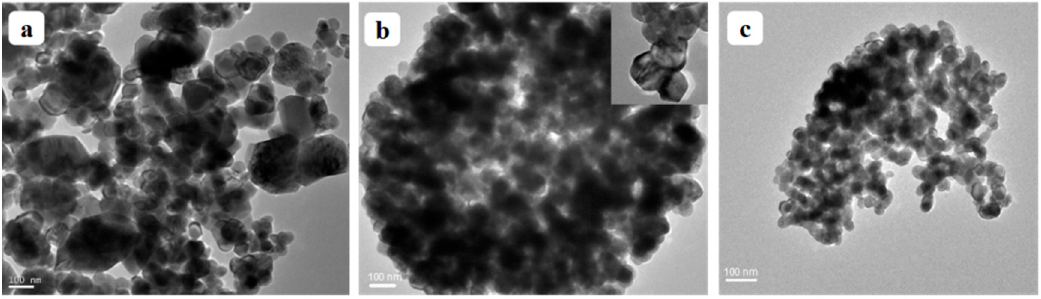
Figure 3. TEM images of the samples ZnO-0 ( a ); -2 ( b ) and -4 ( c ).